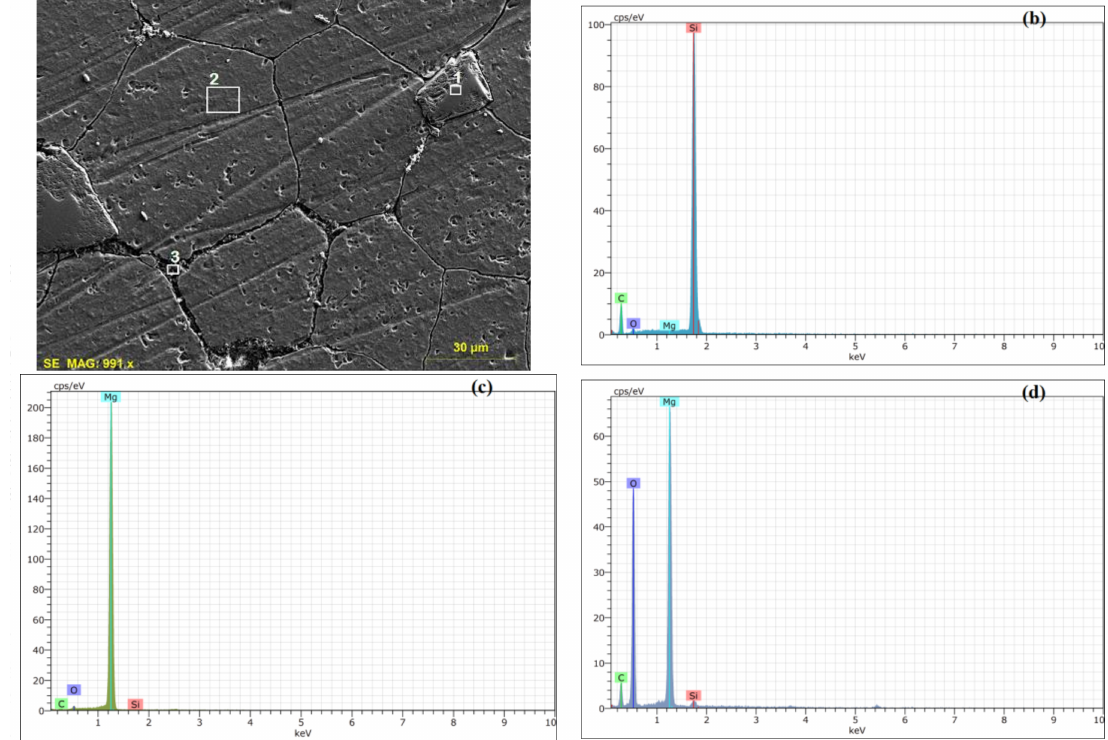
Figure 4. ( a ) SEM image of Mg/10 wt %SiC/0.25 wt %GNPs hybrid MMC; ( b ) EDS peaks for area No.